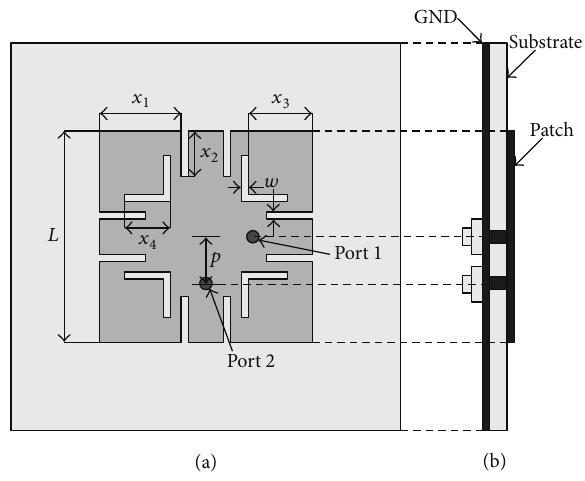
Figure 1: Geometry of the antenna: (a) front view; (b) lateral view.